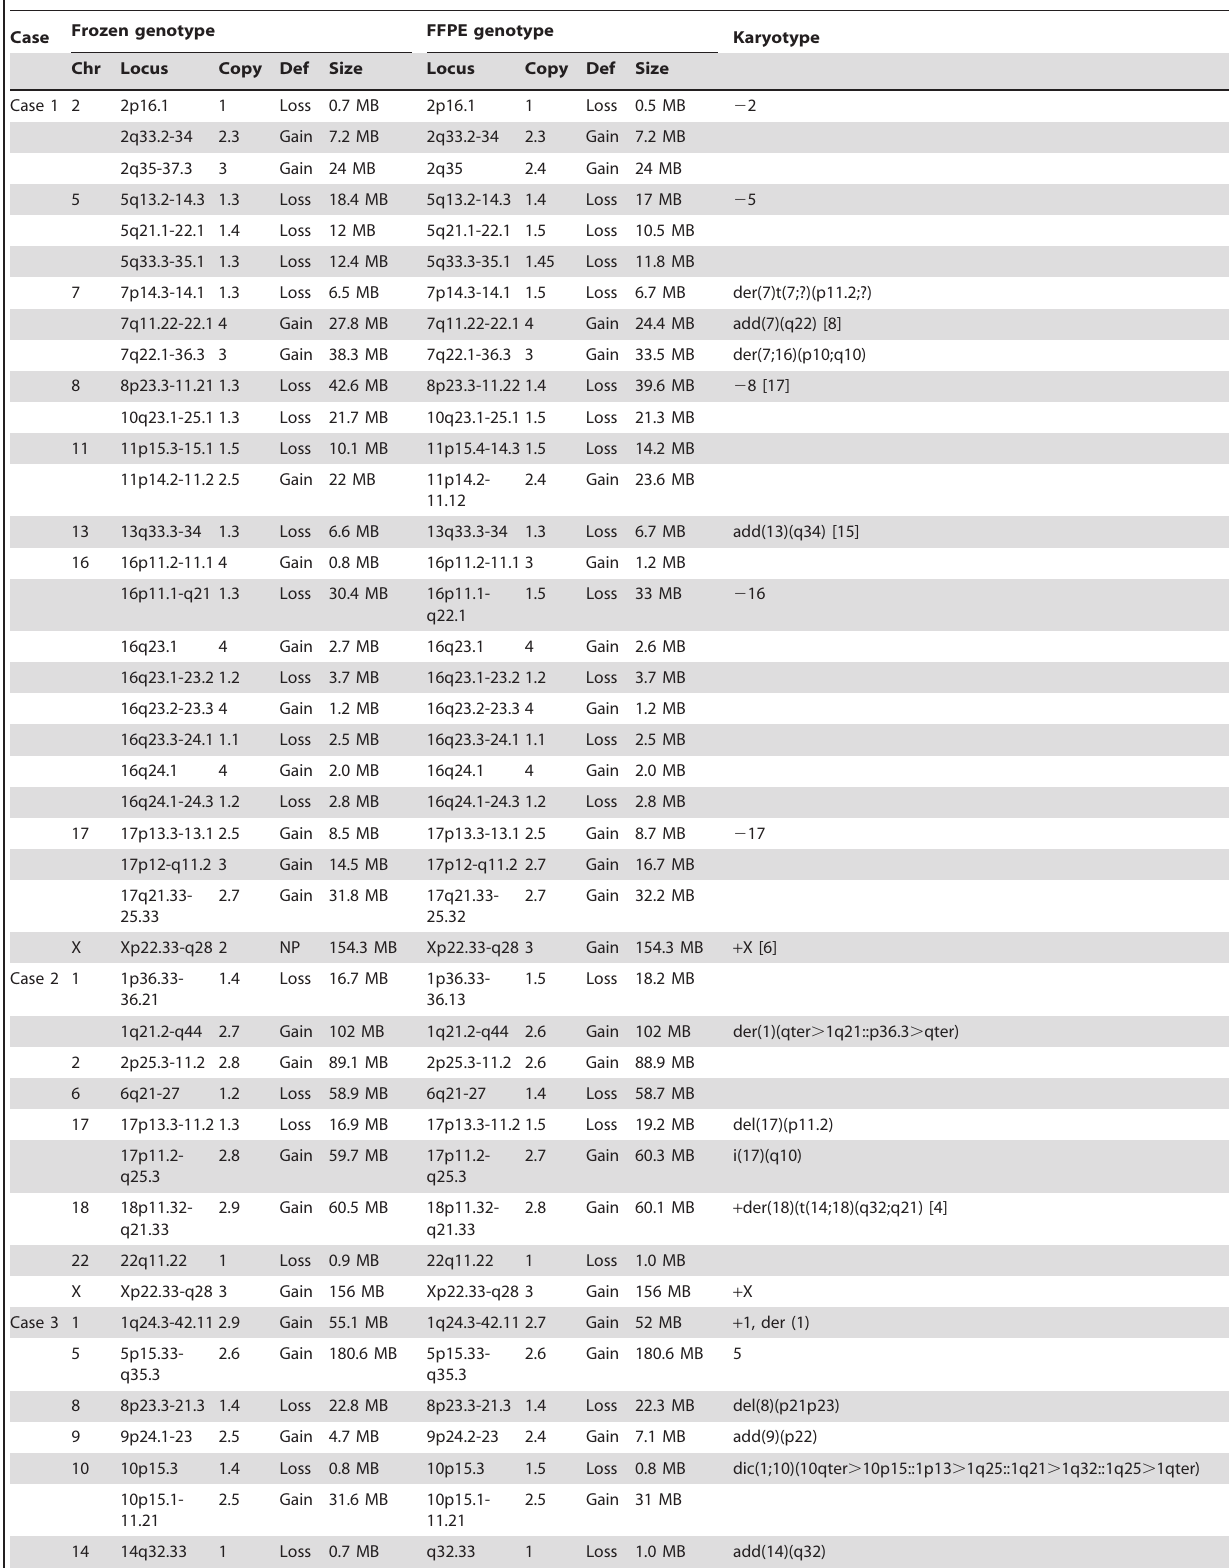
Table 1. Genotyping concordance between FFPE and Frozen